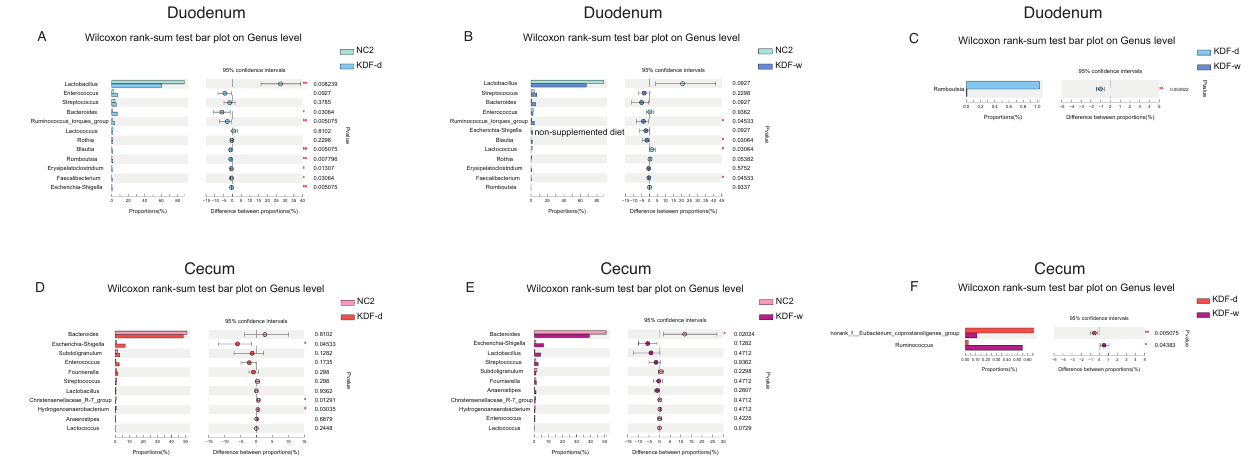
Figure 6. Changes in the intestinal microbiota of chickens in different groups at the genus level. ( A ) Duodenum contents in the NC2 group compared with those in the KDF-d group. ( B ) Duodenum contents in the NC2 group compared with those in the KDF-w group. ( C ) Duodenum contents in the KDF-d group compared with those in the KDF-w group. ( D ) Cecum contents in the NC2 group compared with those in the KDF-d group. ( E ) Cecum contents in the NC2 group compared with those in the KDF-w group. ( F ) Cecum contents in the KDF-d group compared with those in the KDF-w group. NC2: chickens supplied with non-supplemented diet and water without infection (n = 6); KDF-d: chickens supplied with 0.5% KDF in diet without infection (n = 6); KDF-w: chickens supplied with 0.1% KDF in drinking water without infection (n = 6). * p < 0.05, ** p <